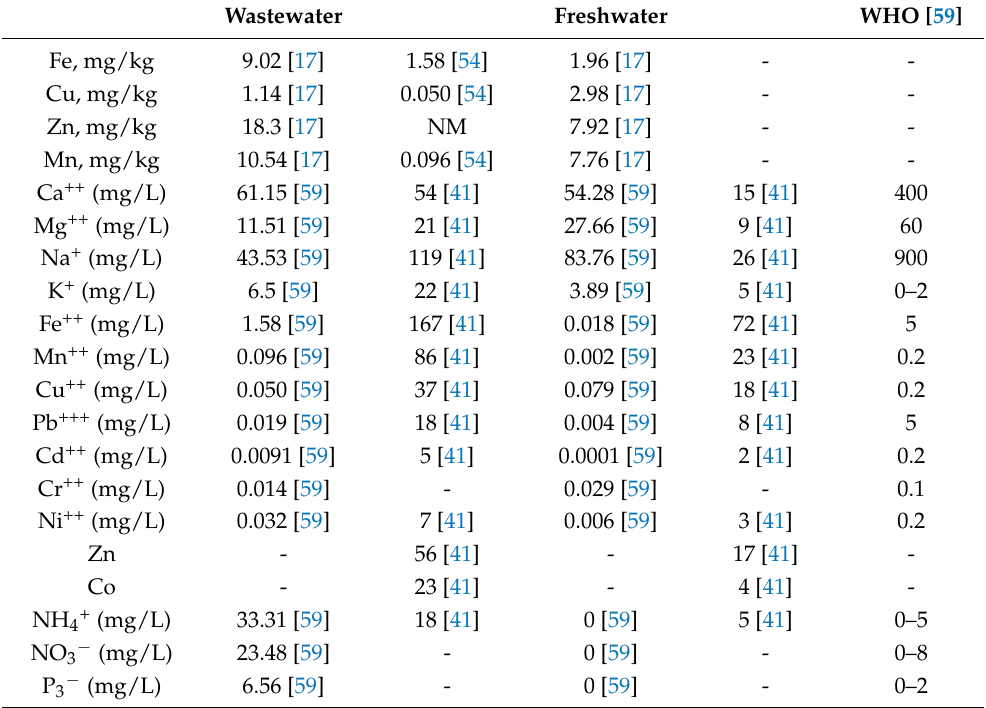
Table 3. The concentration of nutrients and metals in soils irrigated with fresh water and wastewater (data from